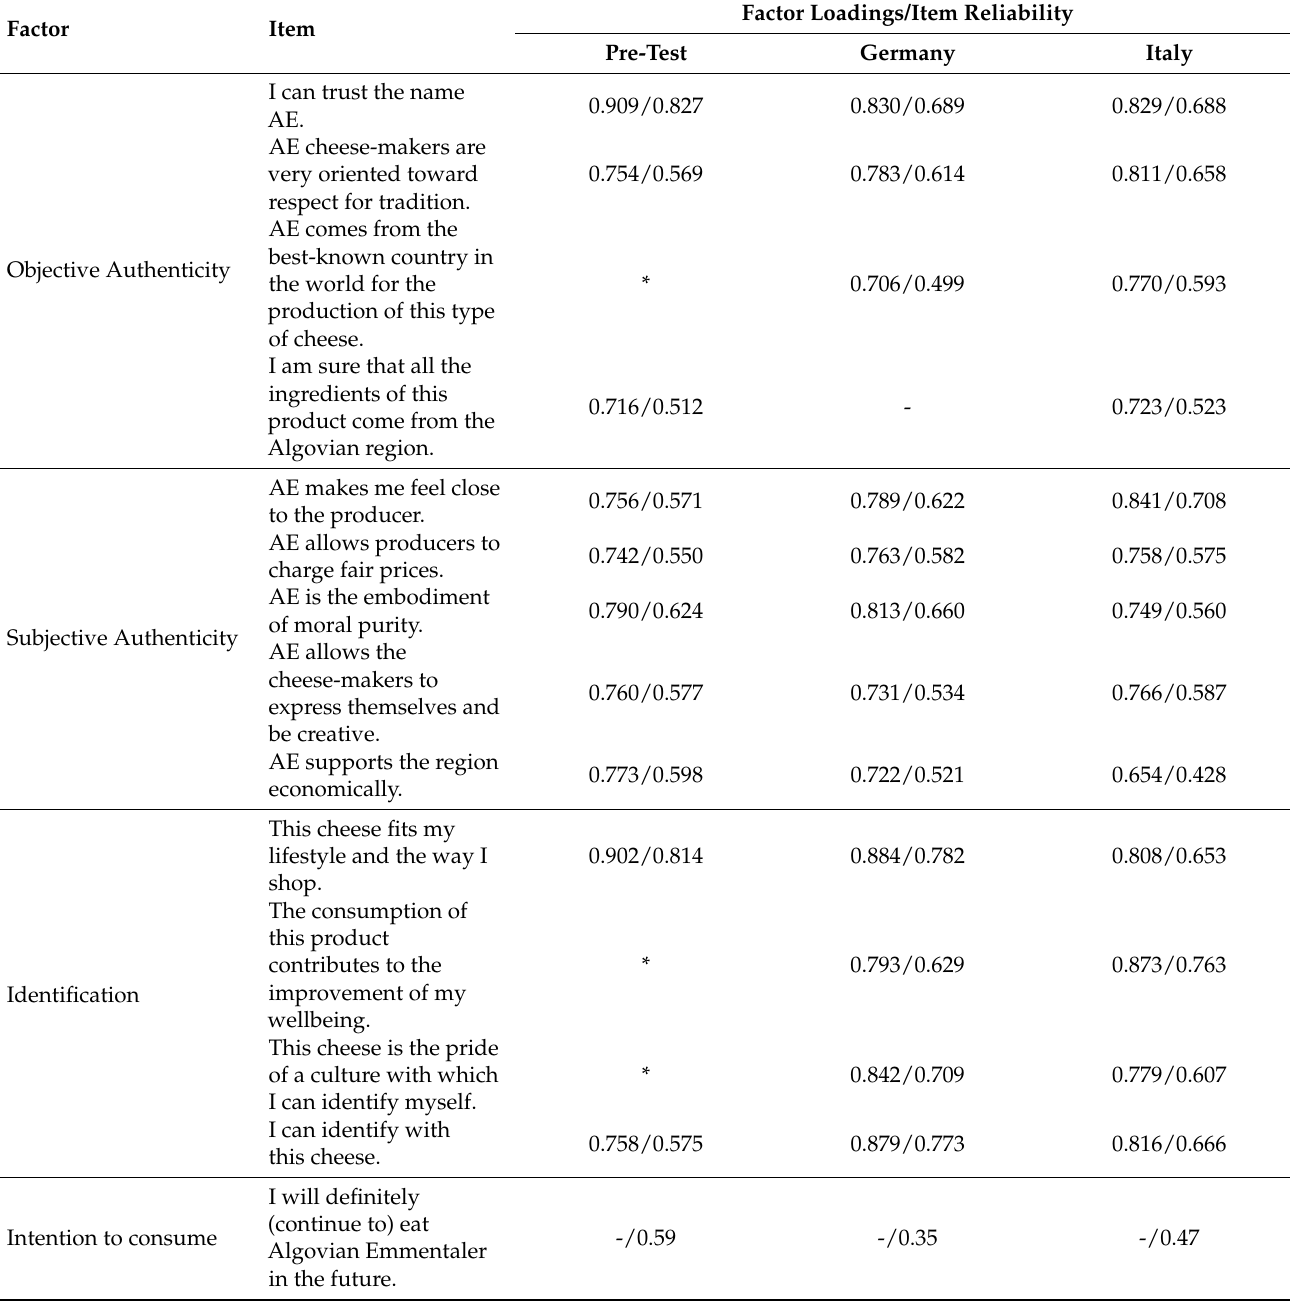
Table 2. Confirmatory factor